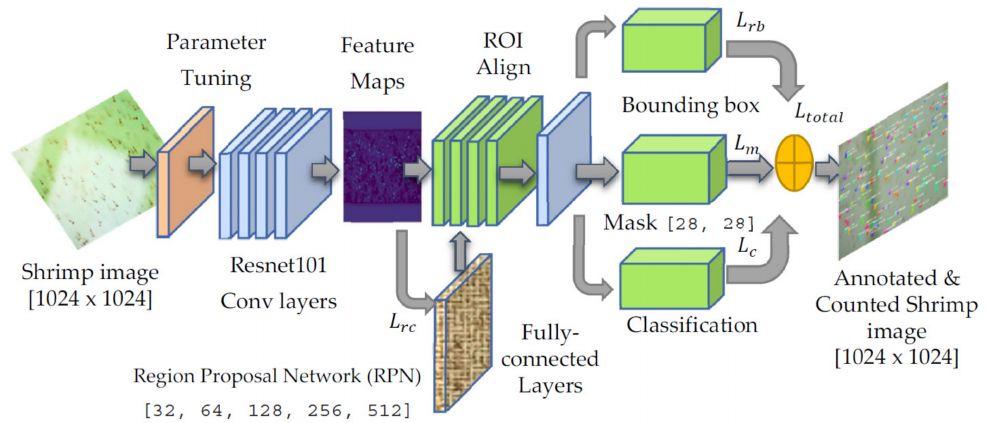
Figure 3. Algorithm for improved Mask R-CNN with parameters calibration